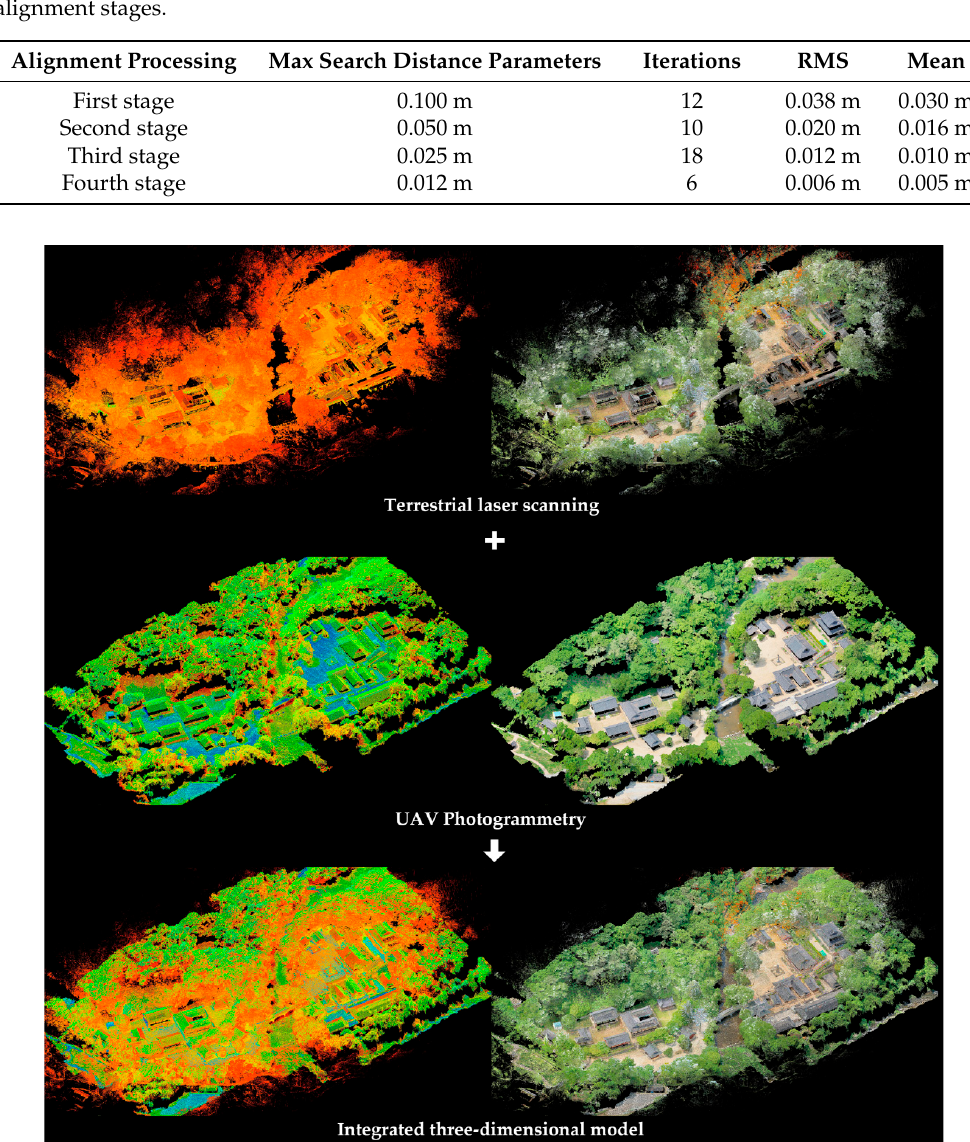
Table 3. Overlap error statistics between the laser scanning and photogrammetry according to alignment stages.